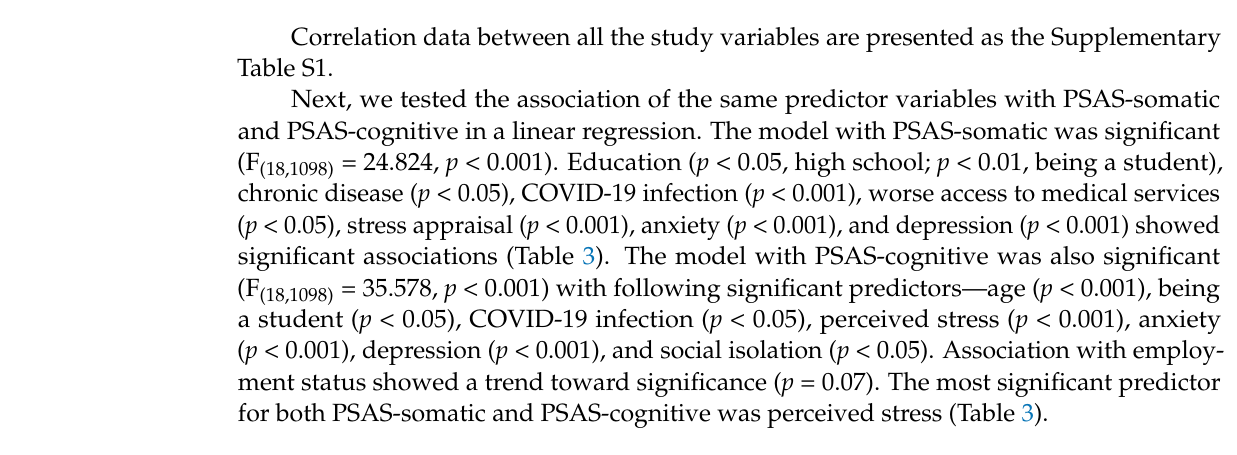
Table 3. Multiple linear regression results for PSAS-somatic and